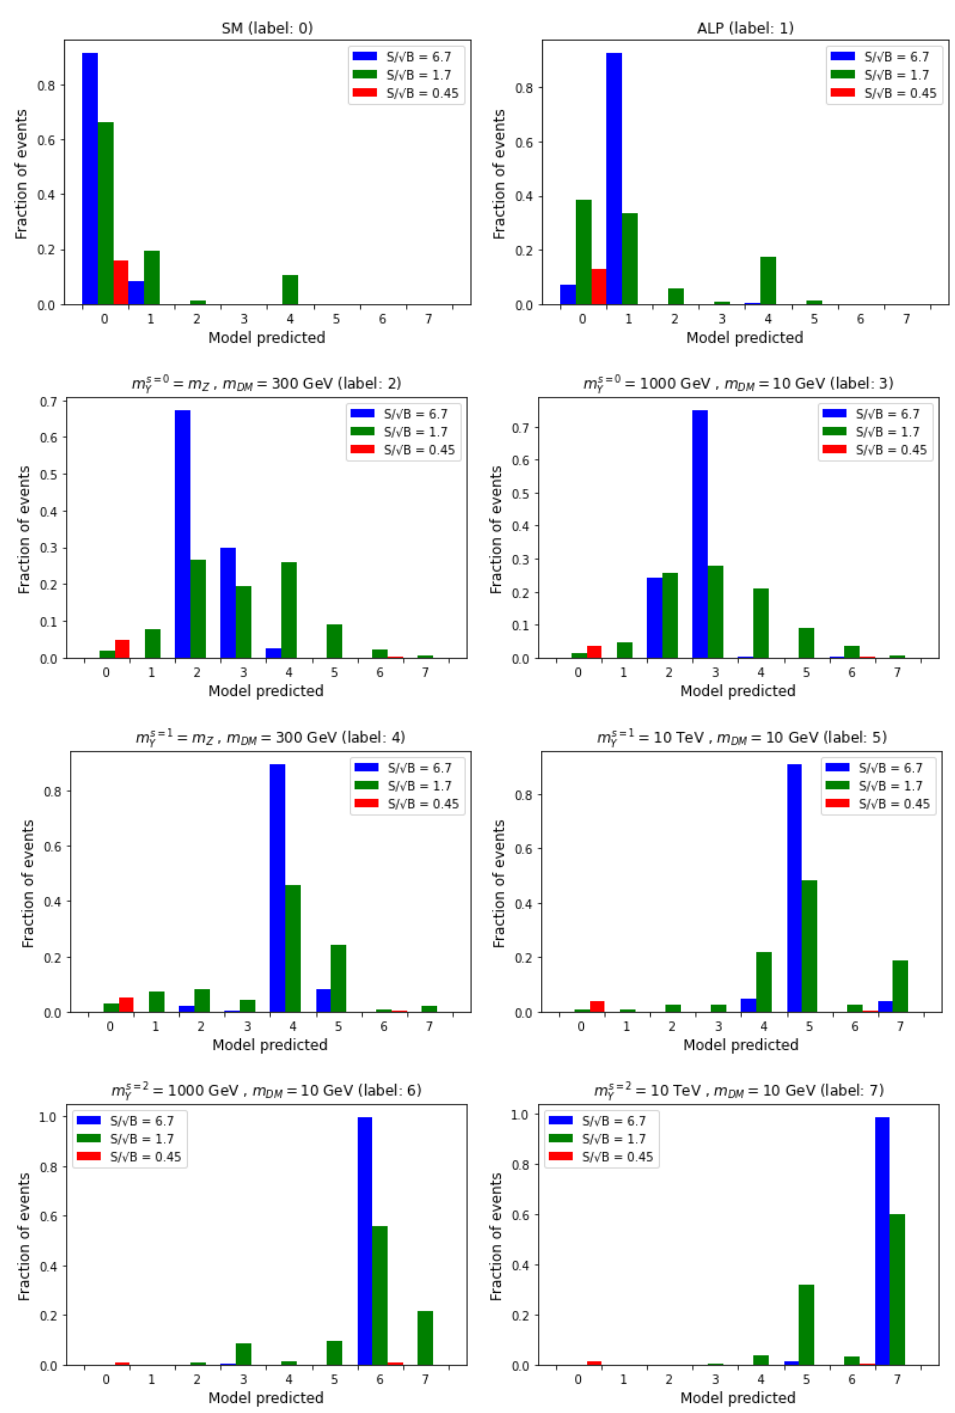
Figure 17: Models predicted by the multiclass DNN applying test samples generated with the eight selected training models (see Table 1). Results for histogram samples with three signal-to-background values are shown, S /